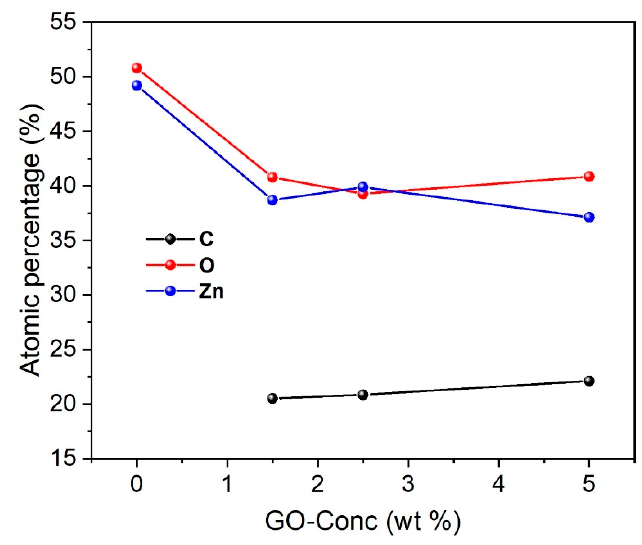
Figure 5. The atomic composition of the ZnO NRs/GO nanocomposites with the different GO